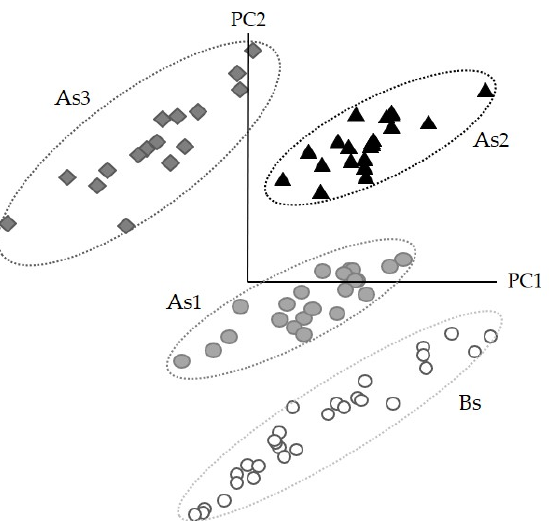
Figure 9. Soft independent modeling of class analogy class projection of FTIR spectroscopy spectra (3000–2700 cm − 1 and 1800–1200 cm − 1 ) from a 4-class SIMCA A. diaperinus snack model. Abbreviations used: Bs, blank snack with 0% insect powder; As 1 , snack with 7.2% of A. diaperinus powder; As 2 , snack with 14.4% of A. diaperinus powder; As 3 , snack with 21.9% of A. diaperinus powder.